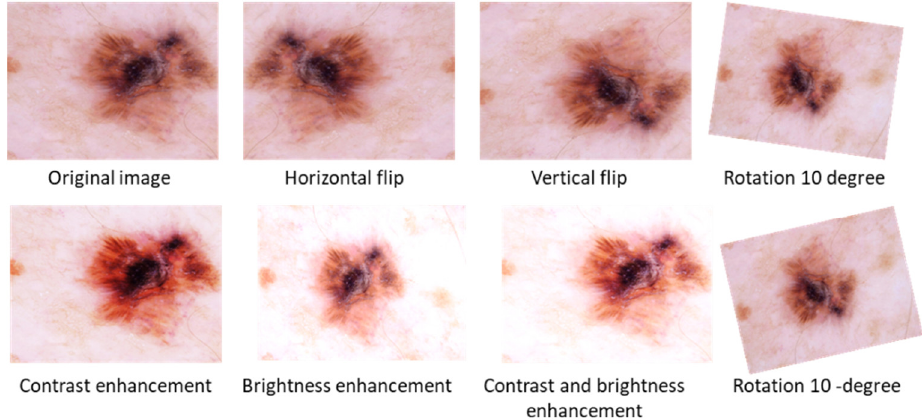
Figure 1. Visual effects of data augmentation steps .